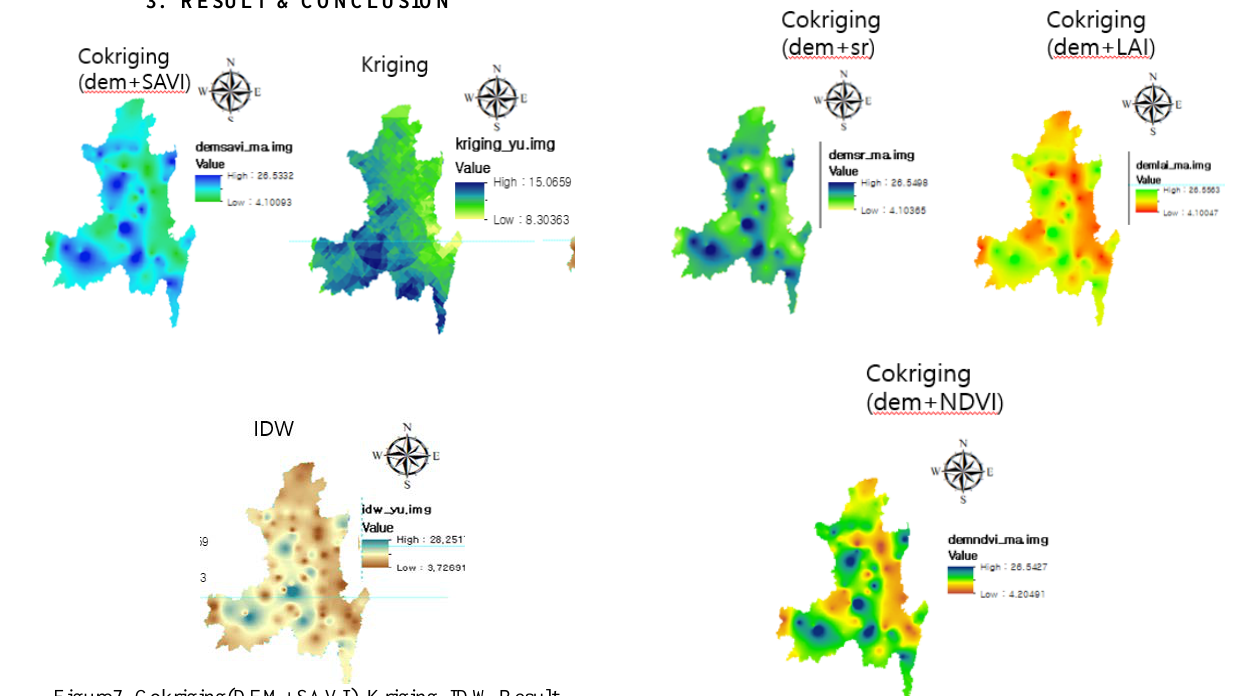
Figure7. Cokriging(DEM+SAVI), Kriging, IDW Result